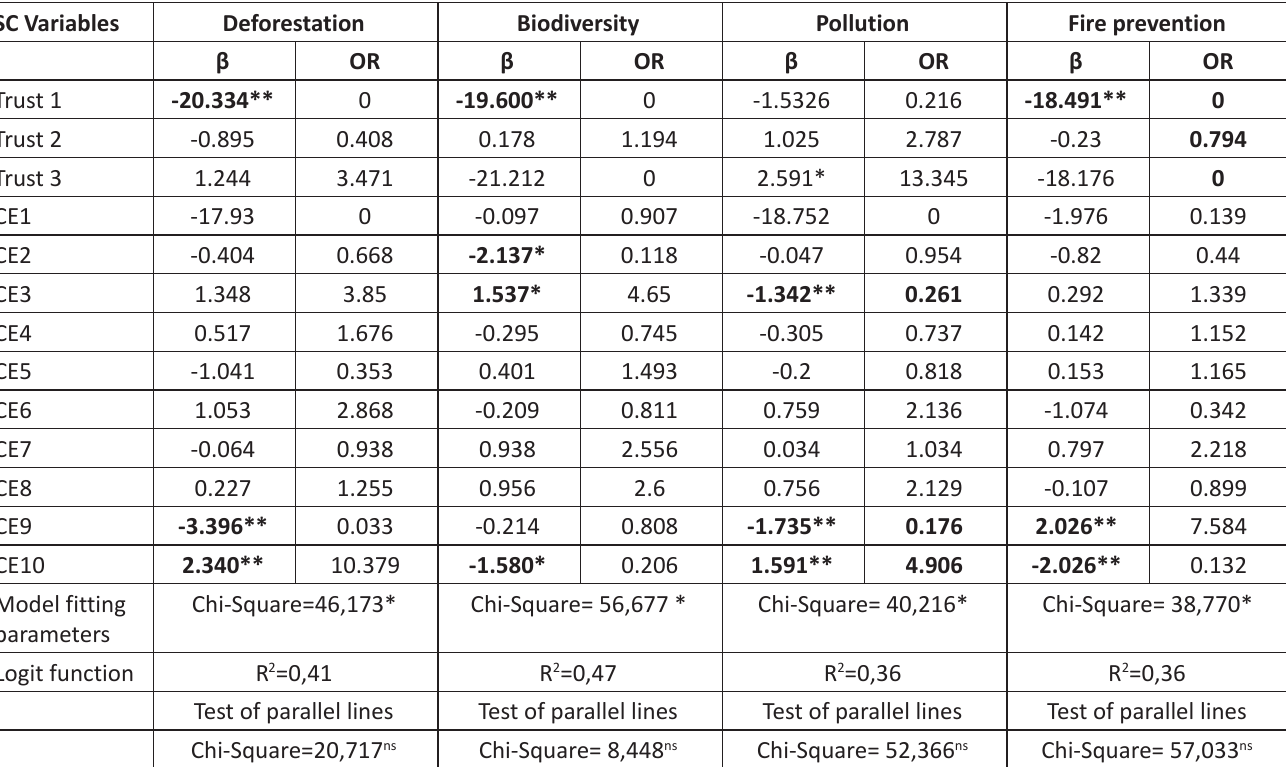
Table 3. Results of proportional odds model results linked to environmental ES provided by the pastoral ecosystem and social capital indicators.